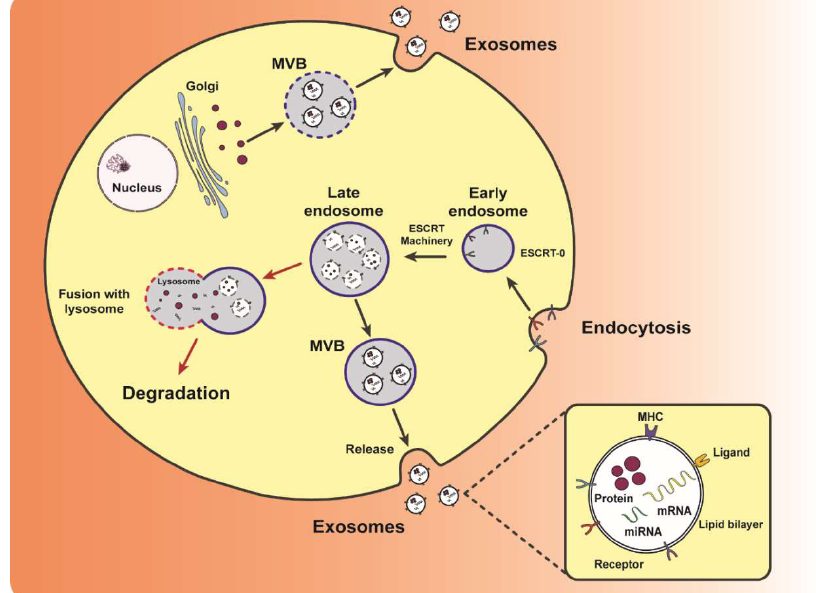
Figure 3. Schematic representation of exosome biogenesis and release. Biogenesis of exosomes via the ESCRT-dependent and –independent pathways are depicted. ESCRT-dependent biogenesis begins with the inward budding of the cell membrane with aid from ESCRT-0 to form early endosomes. The other ESCRT complexes aid in the packaging of exosome contents into late endosomes. These endosomes can either fuse with lysosomes to be degraded or develop into MVBs and release exosomes into the extracellular space. ESCRT-independent biogenesis includes packaging of proteins from the Golgi into exosomes within MVBs and released into the extracellular space. A wide variety of cargo can be encapsulated within exosomes, such as mRNA, miRNA, proteins. The biogenesis of exosomes in MVBs can be delineated into two major pathways: (1) endosomal sorting complex required for transport (ESCRT)-dependent and (2)